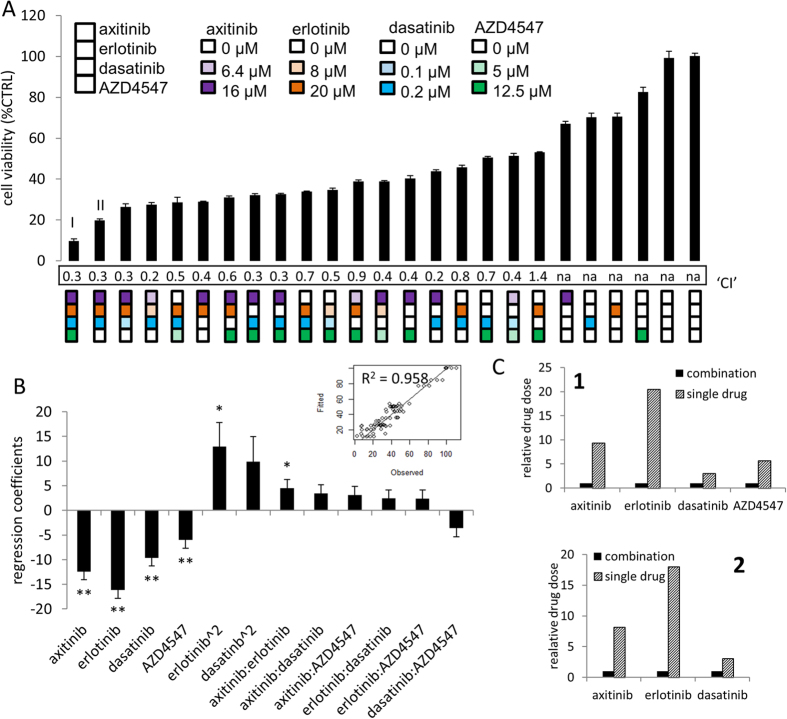
Identification of the optimal drug combination for the inhibition of 786-O cell viability based on results from Searches 1 and 2.2.(A) Cell viability inhibition efficacy of each drug combination tested in Search 3. The square icons present the specific combinations, where each position in the square and color corresponds to a specific drug (i.e. the top square and color purple indicate axitinib and the concentrations (μM) of each compound are represented by the different patterns). The most promising combinations, labeled I and II, represent a mean of at least three independent experiments, with three replications each, and error bars represent the SEM. (B) Regression coefficients from the fit with the second-order stepwise linear regression model based on the data of Search 3. Insets in B show the linear fit of modelled data with theoretical quartiles versus standardized residuals and the corresponding R2-values for each model. (C) Relative drug dose required to obtain an equivalent level of efficacies as seen for the combinations I and II when drugs are applied in combination or individually.